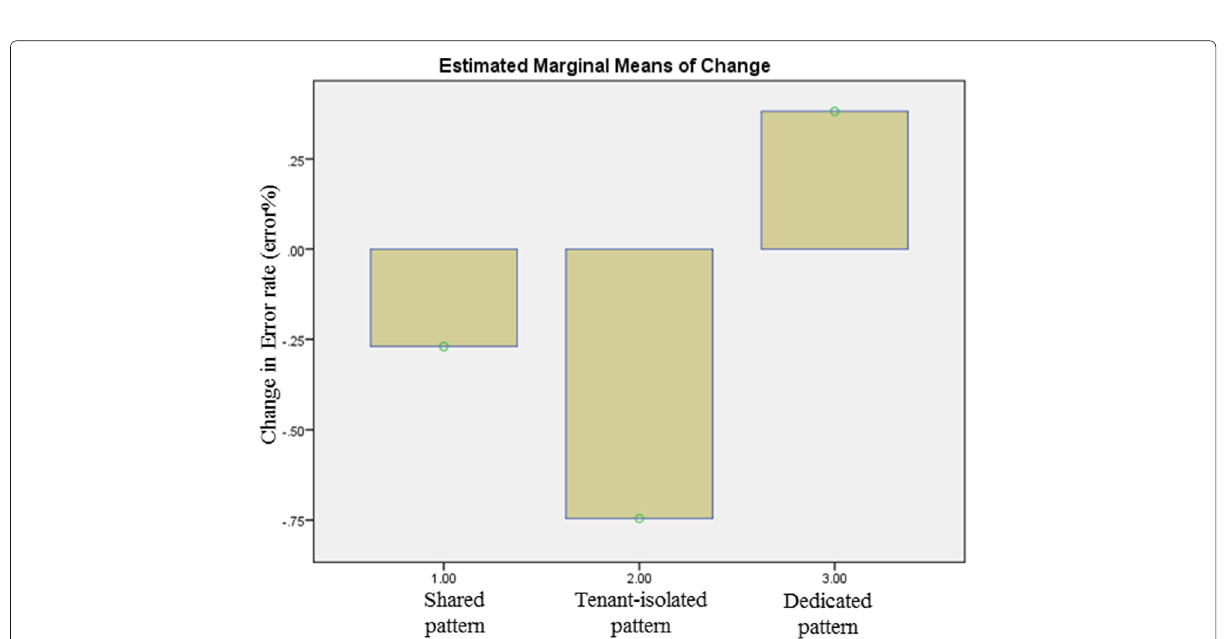
Fig. 16 Changes in Error%